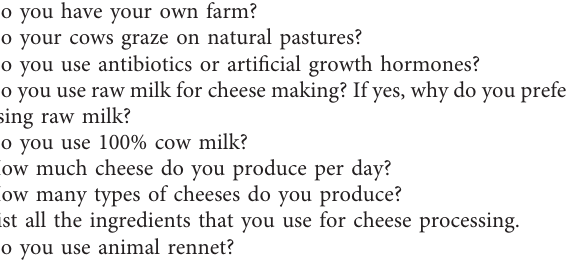
Table 1: Questions posed to the